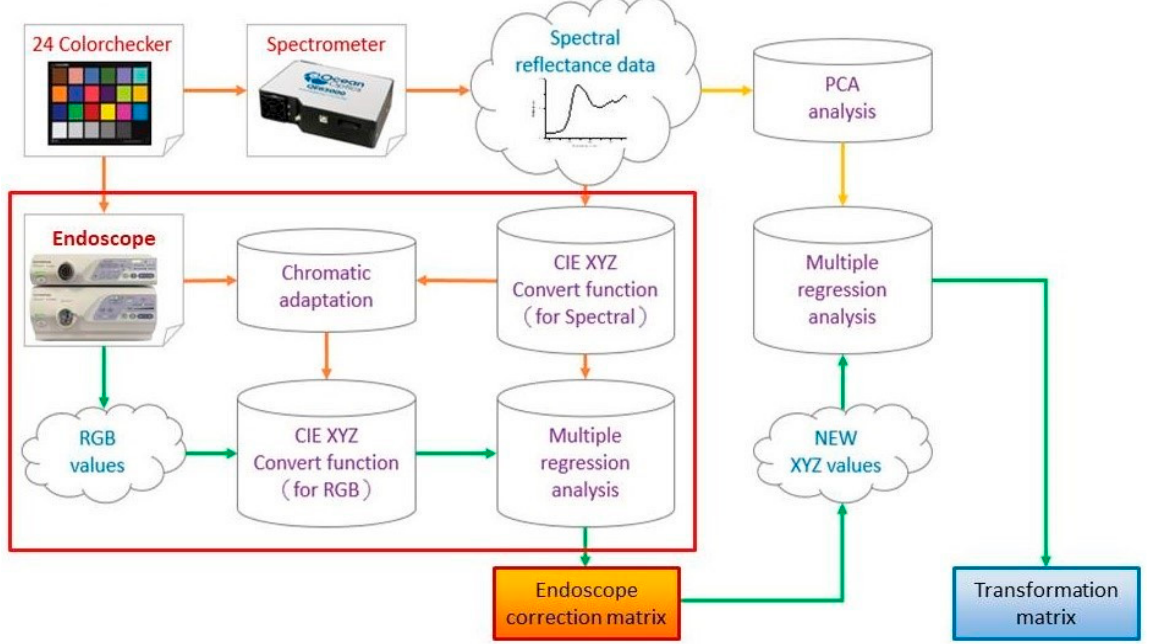
Figure 1. The flow chart of spectrum conversion construction, using standard 24 color blocks (X-Rite Classic, 24 Color Checkers) as the common target object for spectrum conversion of the endoscope and spectrometer, converting the endoscopic images into 401 bands of visible light spectrum information.